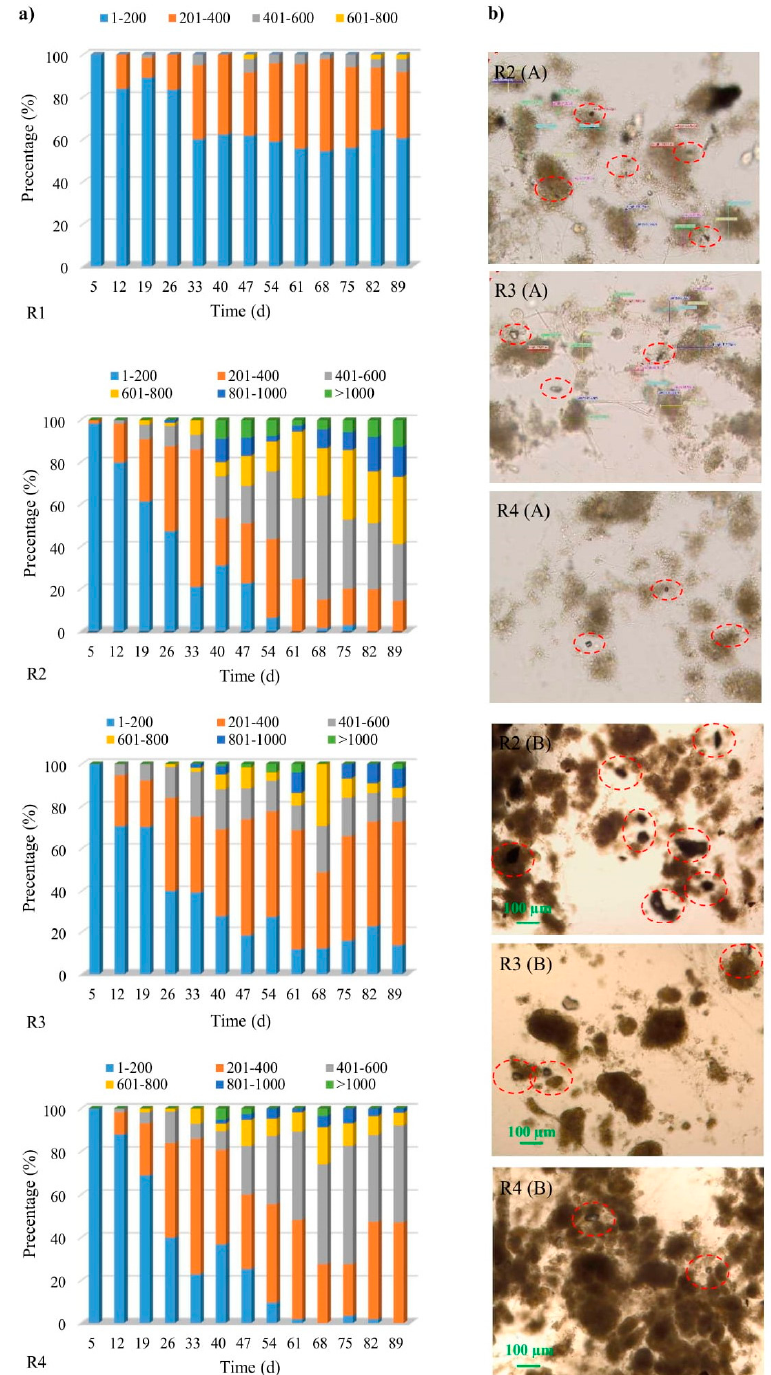
Figure 1. The biogranulation process including the percentage of granules of a given range of diameters ( a ), and the powdered mineral materials in the structures of flocs and granules: A—5th day of research, B—19th day of research ( b ).